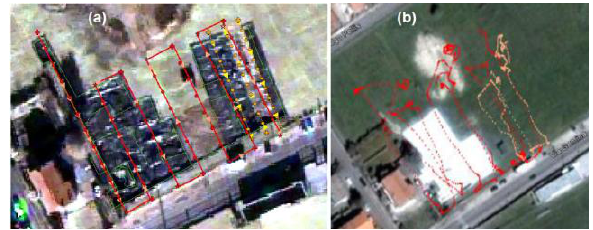
Figure 4. The flight planning on the Quickbird orthophoto (a) and the real trajectories followed by the aircraft (b): red lines described the highest flight and orange lines the lowest flight From the plan of the flight, the coordinates of the start and end points of each strip have been extracted (indicated by, respectively, a cross and a star in Figure 4 (a)) and subsequently inserted into the control software of the ground station and sent wireless connection (see Figure 5).